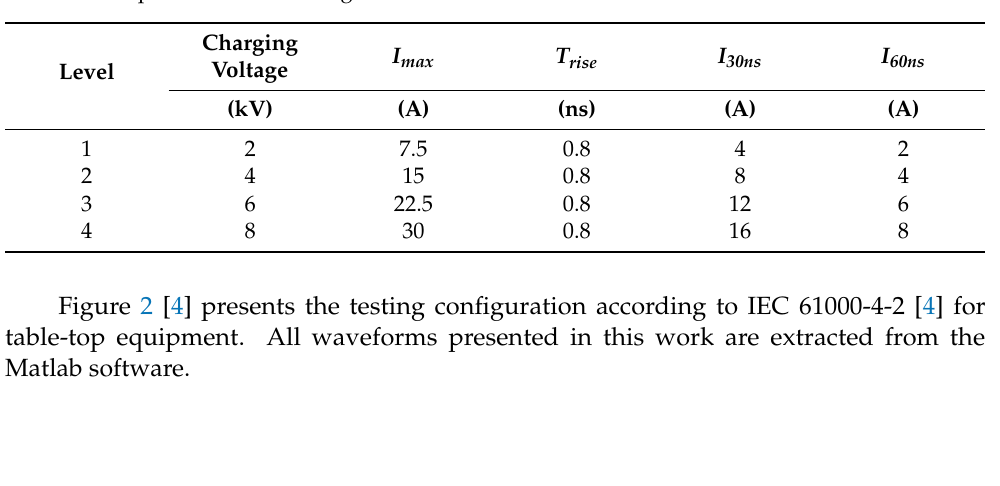
Figure 1. 4 kV electrostatic discharges (ESD) current waveform according to IEC 61000-4-2. Table 1. ESD parameters according to IEC 61000-4-2. Table 1. ESD parameters according to IEC